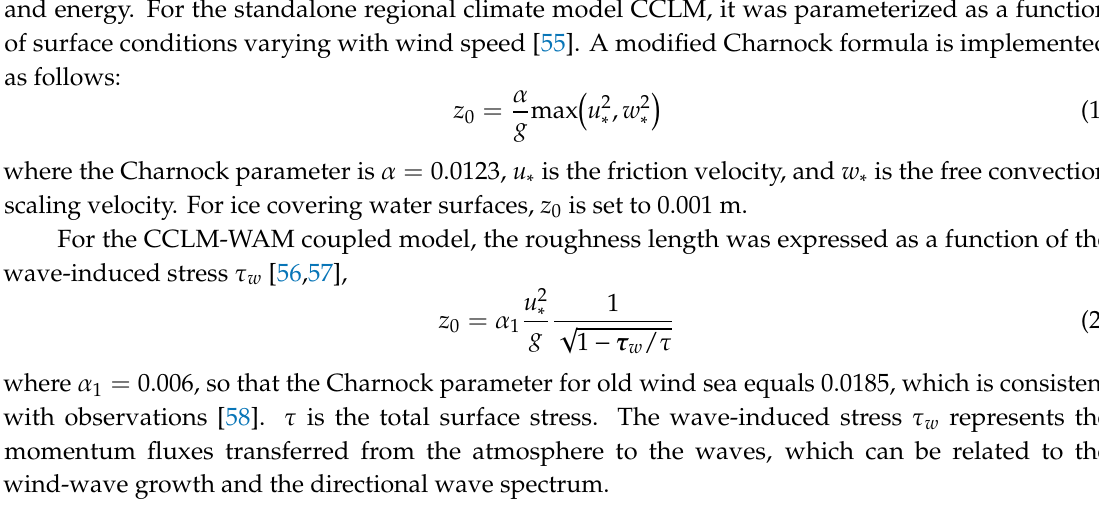
Table 2. List of station observations at buoy station and platform. Observation parameters